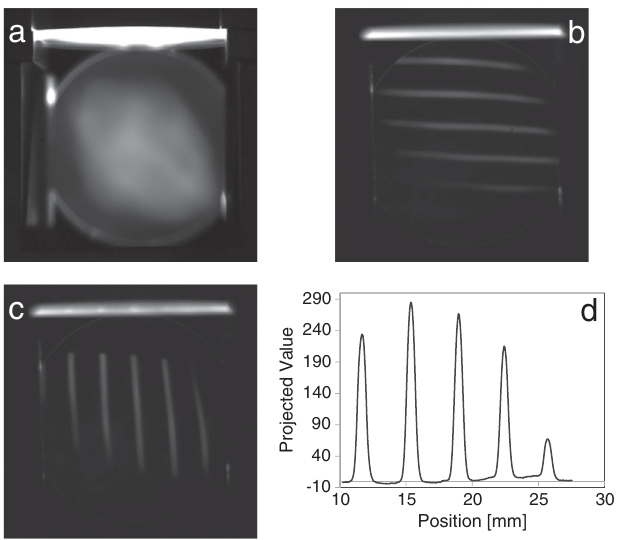
FIG. 20. Images used in emittance measurements, showing (a) YAG screen image of the beam; (b) horizontal and (c) vertical beamlet images; and (d) projected profile for hori- zontal beamlets. In images (a), (b), and (c), the edge of the YAG screen is visible as a bright rectangle at the top of the image due to guiding of a significant amount of light inside the YAG crystal.